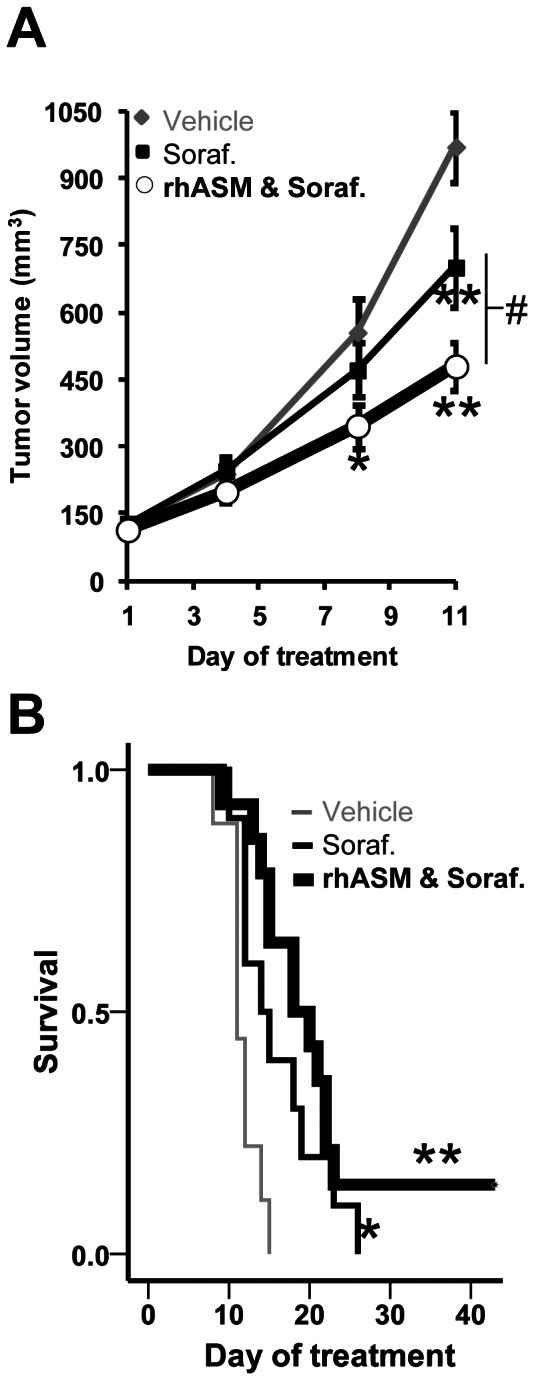
rhASM/sorafenib co-treatment reduces tumor volume and shows a trend towards improved survival in mice bearing subcutaneous Huh7 xenografts versus sorafenib alone.(A) The mean tumor volume of mice treated with rhASM and sorafenib was significantly smaller than that of control mice at day 8 (Dunnett's post-hoc test p = 0.035; ANOVA df (2,30), F = 3.24, p = 0.053). At day 11 both sorafenib (Dunnett's post hoc test p = 0.034) and combined rhASM and sorafenib (Dunnett's post hoc test p<0.001) treated mice had smaller tumors than control mice (ANOVA, df (2,27), F = 12.22, p<0.001). The rhASM/sorafenib combination group also had significantly smaller tumors than the sorafenib group at day 11 (t = 2.32, df (20), p = 0.031). (B) Significantly longer median survival (13 days) of sorafenib treated mice (chi-square 5.02, df (1), p = 0.025) and combined rhASM/sorafenib treated mice (19 days) (chi-square 14.57, df (1), p<0.001) was observed compared to control (11 days). Two mice in the rhASM/sorafenib group lived beyond the 5 week study period, and were eventually sacrificed at day 43 (tumor volume 132 mm3, 267 mm3). *, # p<0.05, ** p<0.001.